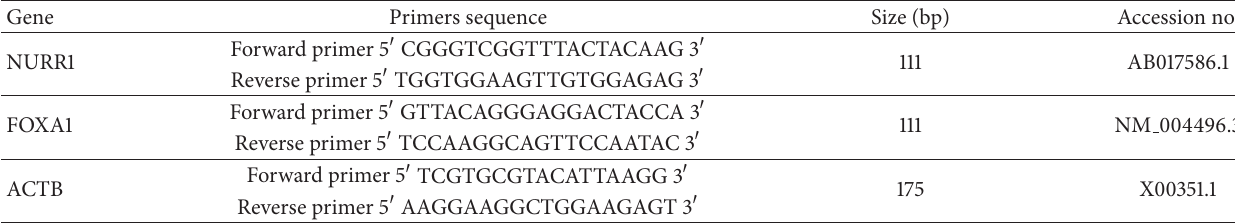
Table 1: Genes with corresponding primers which are used for gene expression study.